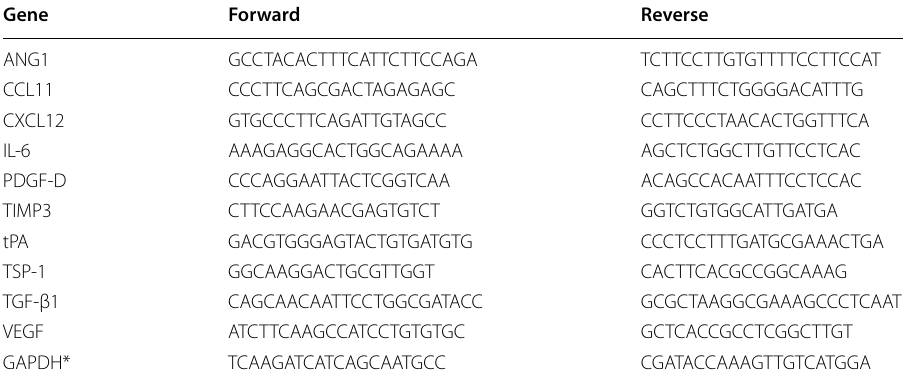
Table 1 Sequences of primers used during real‑time PCR reactions